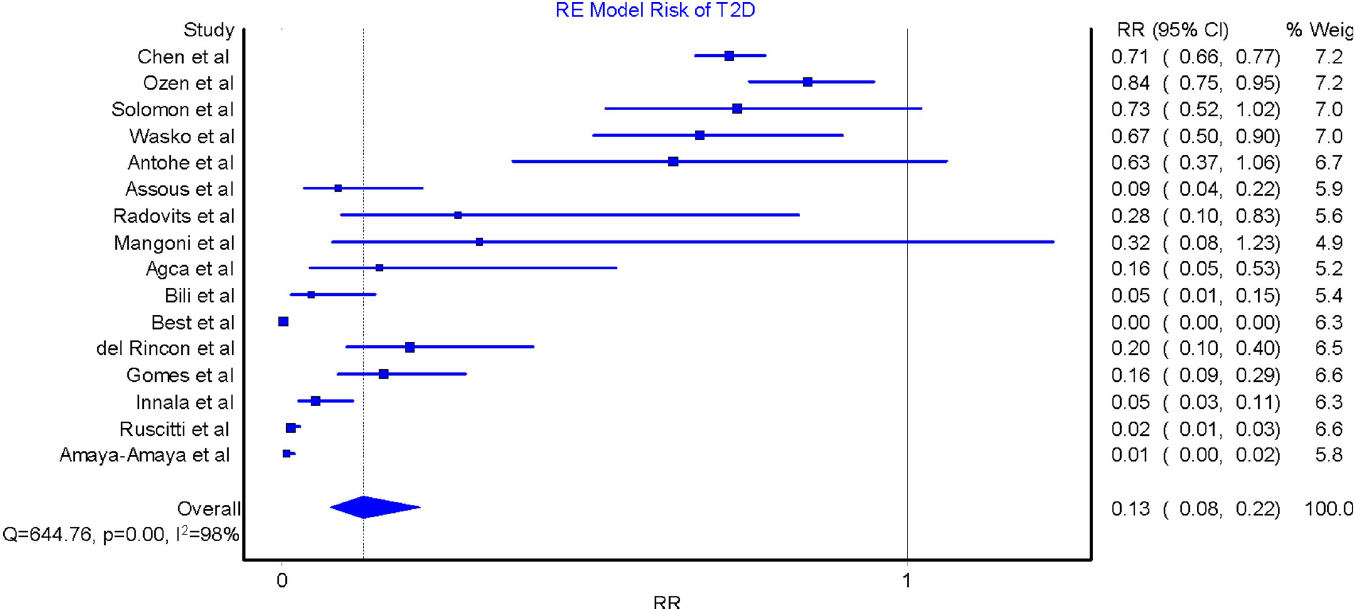
Fig 3. Relative risk of type 2 diabetes in rheumatoid arthritis patients on methotrexate versus those not taking methotrexate. RE = random effects model; RR = relative risk; T2D = type 2 diabetes.